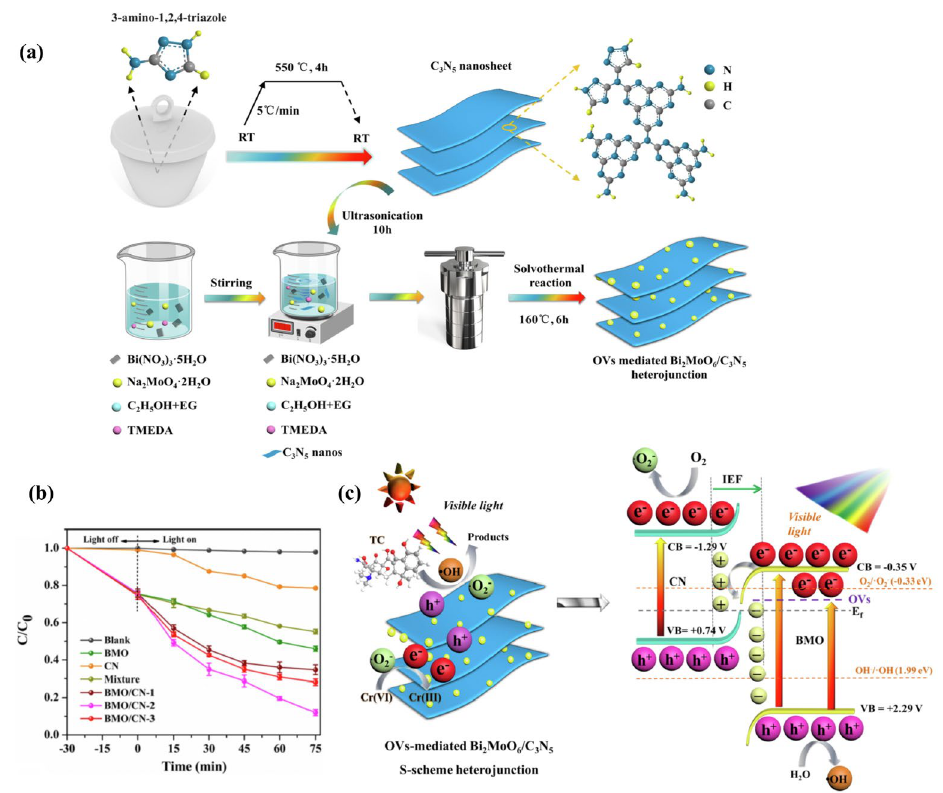
Figure 14. g-C 3 N 5 /Bi 2 MoO 6 S-scheme heterojunction: ( a ) synthetic routes; ( b ) photocatalytic degra- dation of TC; ( c ) S-scheme charge transfer mechanism. Adapted with permission from [45]. Copyright Elsevier Inc, 2022.